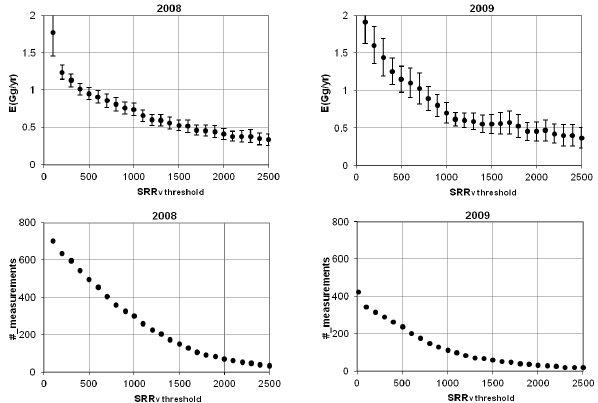
Figure 8. Inferred MCF emissions from the SEF region for SRR v threshold between 0 and 2500sm 3 kg − 1 for the years 2008 and 2009 (top panels). The associated uncertainty is represented by the 95% confidence interval. Only data with SRR v >1500 have been used for the estimation of the fluxes in the rest of the paper. In the bottom panels, the number of measurements for each SRR v thresh- old value are reported.